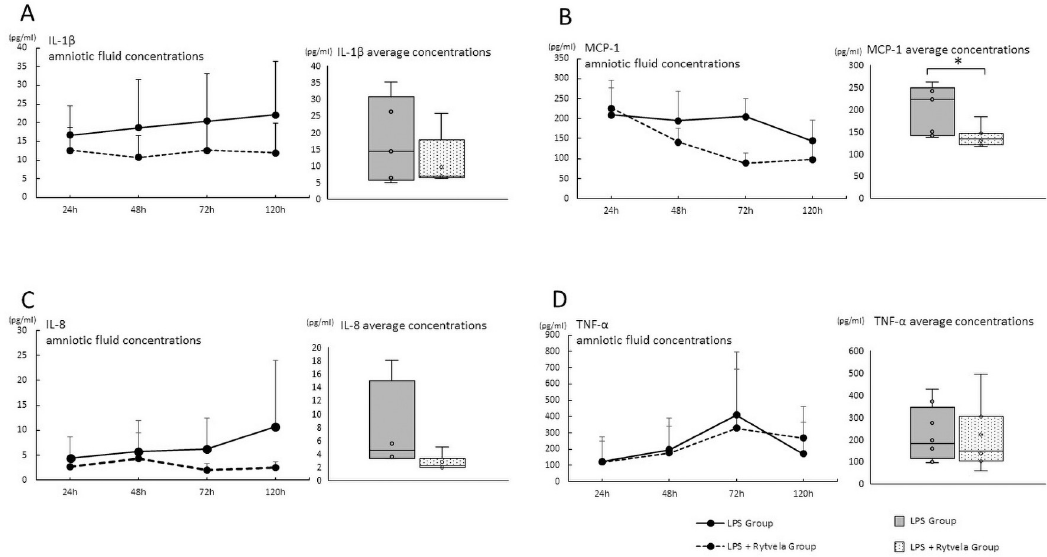
Fig 3. Cytokines/chemokine concentrations in amniotic fluid after the administration of either saline or rytvela). Cytokines/ chemokine concentration in AF at each time point plotted as mean ± SD. Each group’s average concentration is shown in bar charts. A , IL-1 β ; B , MCP-1; C , IL-8; D , TNF- α . The average concentration was compared between the LPS Group and the LPS + rytvela Group. � p < .05 between the LPS Group and the LPS + rytvela Group. n = 3–7 animals/group. AF, amniotic fluid; SD, standard deviation; IL, Interleukin; MCP, monocyte chemoattractant protein; TNF, tumor necrosis